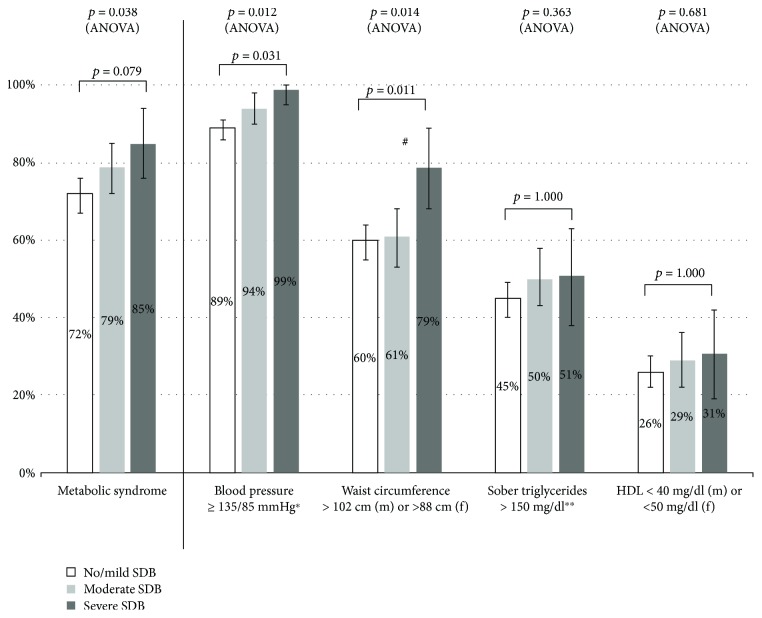
Prevalence of NCEP criteria (except elevated fasting glucose) in participants with no or mild, moderate, and severe SDB. Comparison of the prevalence of NCEP criteria with ANOVA and the post hoc test (Bonferroni) between no/mild and severe SDB. Results are shown with 95% confidence intervals. m: male, f: female; ∗or on antihypertensive medication, ∗∗or on triglyceride-lowering medication. #Significant difference between moderate and severe SDB (p = 0.041).